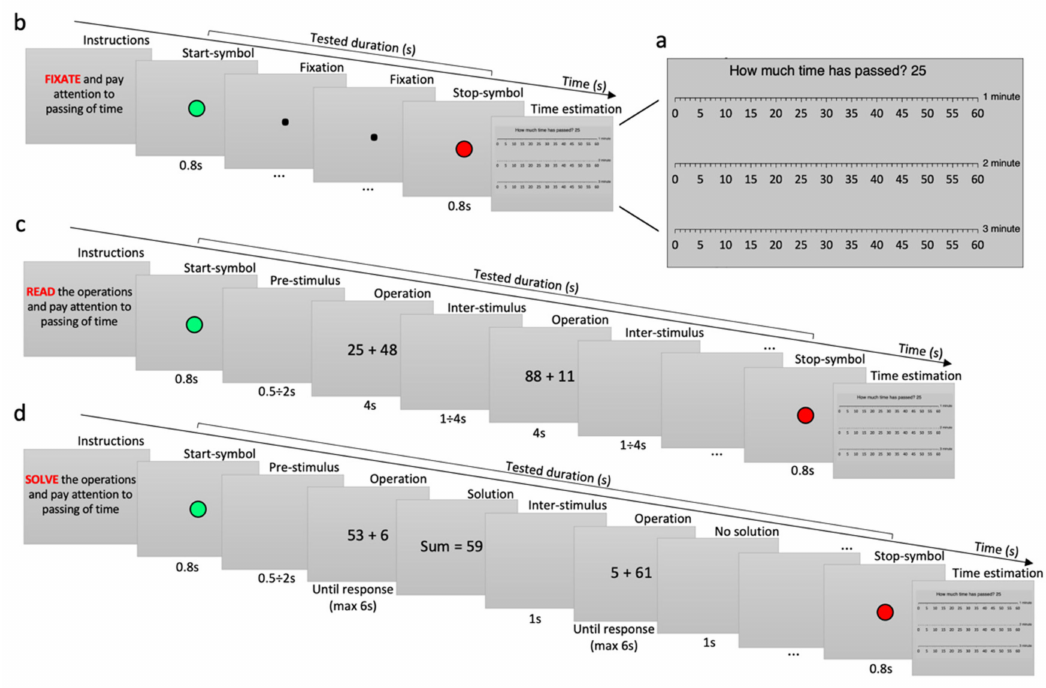
Figure 2. Procedure and tasks. ( a ) Time ruler. Ruler shown at the end of each trial to allow participants to express how much time had passed while they were performing the task. In the example shown, the participant estimated 25 s. ( b ) Look task. ( c ) Read task. ( d ) Solve task. Example of solve simple task. The solve hard task follows the same procedure but consists of harder mathematical sums. Red words report the task to be performed in the trial. The green circle informs the observers to start estimating the passing of time; the red circle informs the observers to stop estimating the passing of